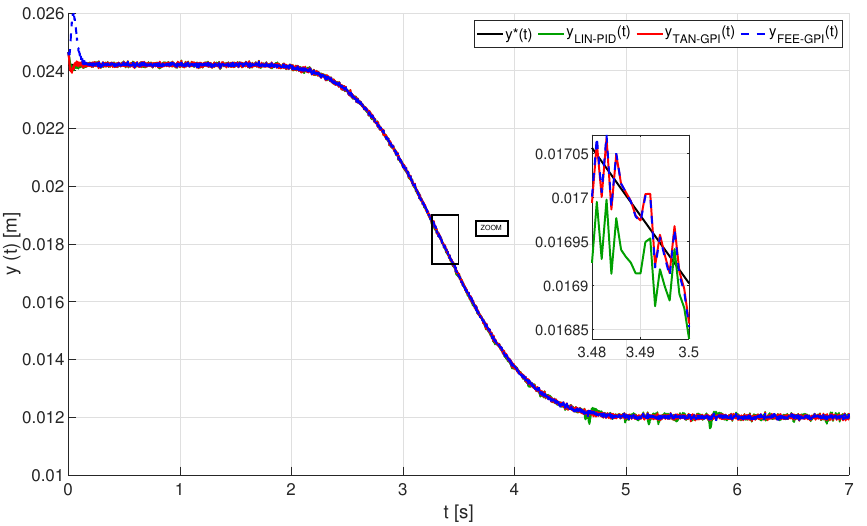
Figure 6. Evolution of the tracking trajectory of the magnetic ball, y ∗ ( t )[ m ] vs. y ( t )[ m ] , with measure- ment noises at the control input and the output of the MLS (Test